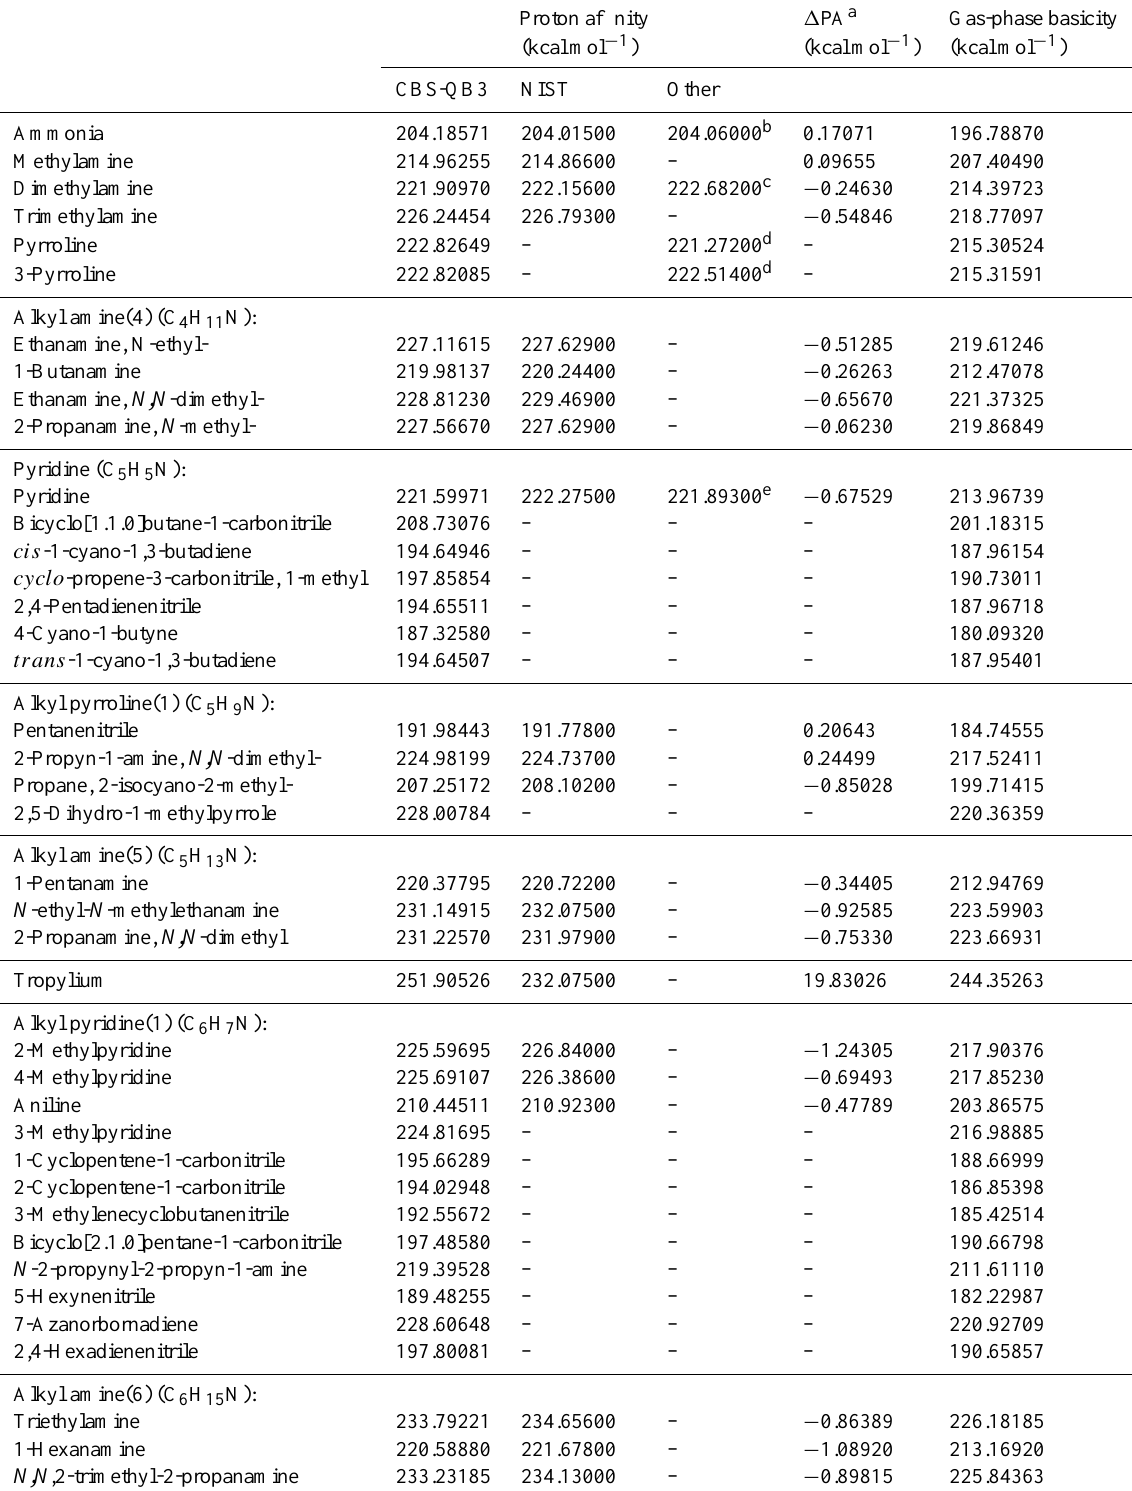
Table 2. Proton affinities and gas-phase basicities of all studied molecules. Values are in kcalmol − 1